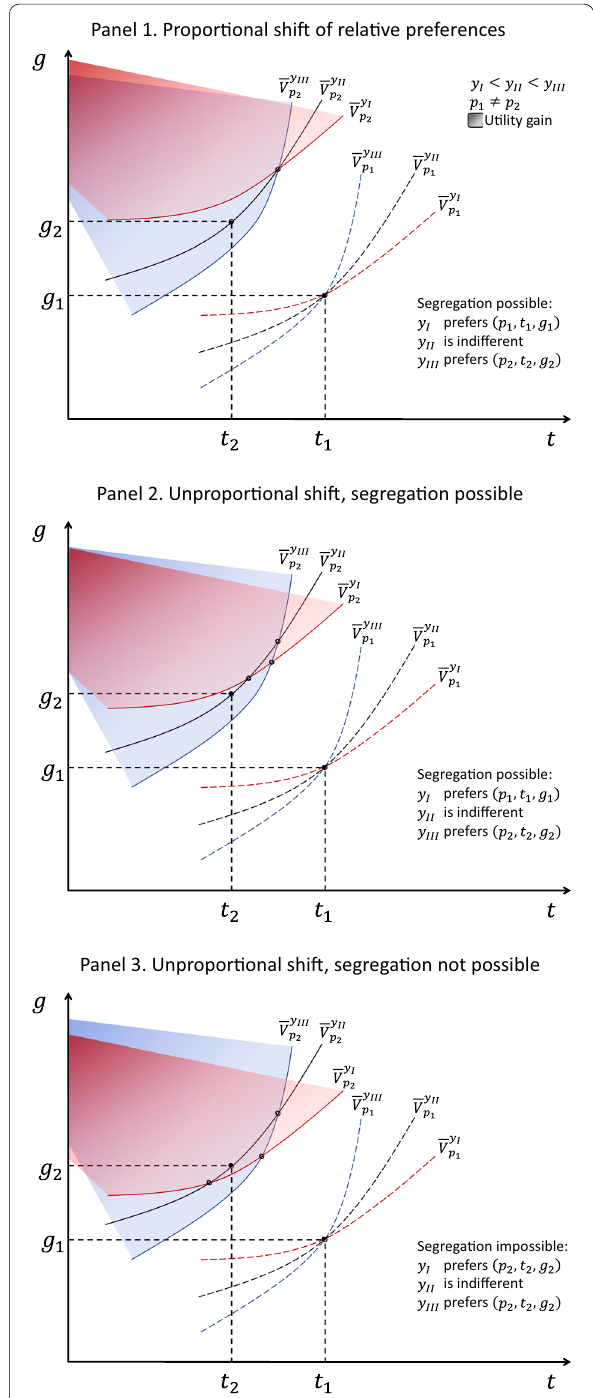
Fig. 6 Indifference curves in the g - t -space for different values of p and y